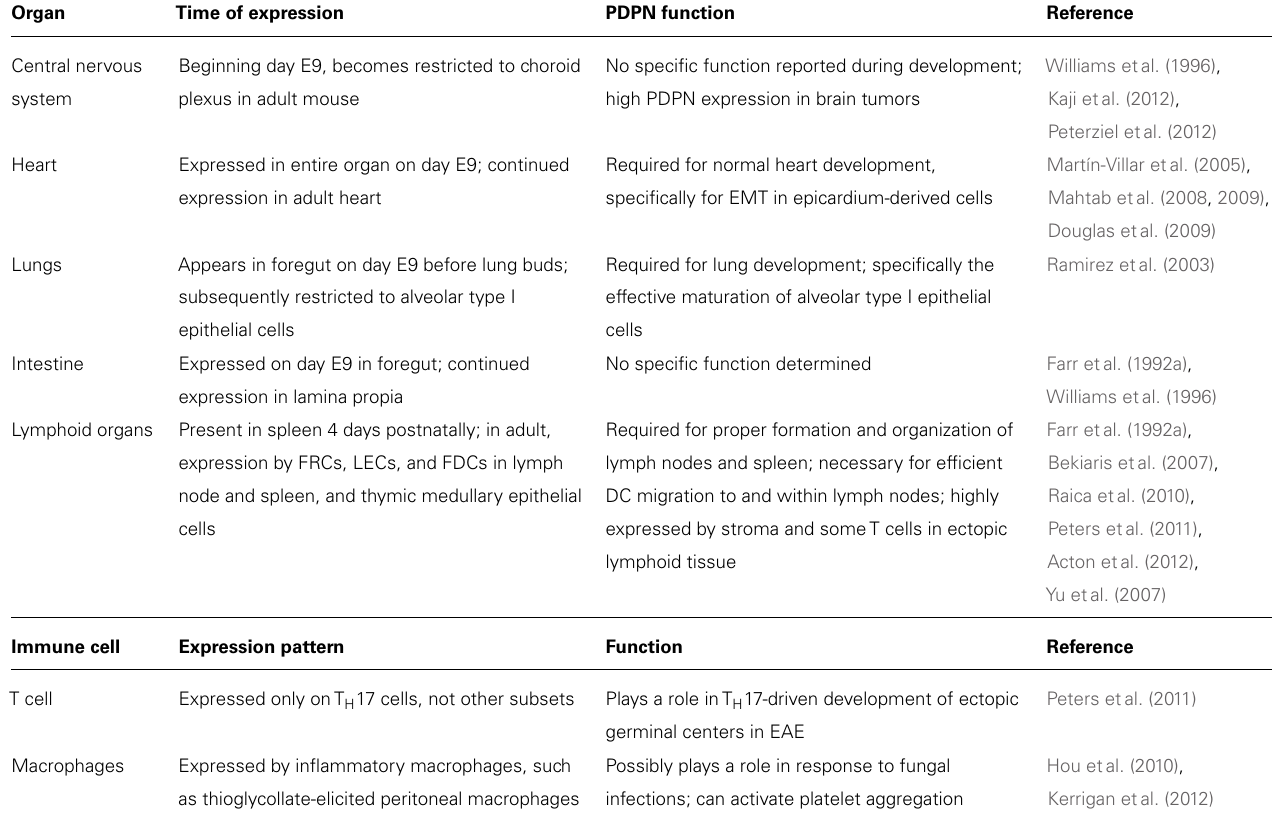
Table 1 | Podoplanin expression and function in organs and immune